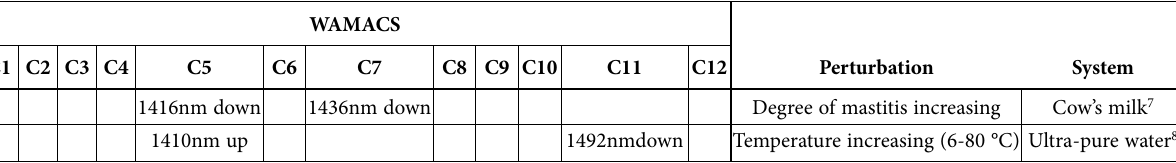
Table 2. Example of two entries in the aquaphotome database in the NIR region (1 st overtone of water OH stretching vibrations, 1300-1600 nm) showing how development of mastitis influences the water matrix of milk and how increasing temperature influences the water matrix of ultrapure